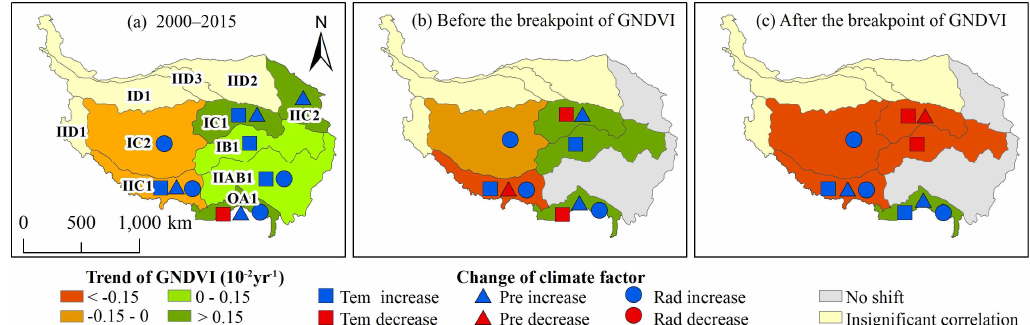
Figure 7. Spatial distribution of changes in growing season NDVI (GNDVI), temperature (Tem), total precipitation (Pre), and radiation (Rad) during different periods before and after the breakpoints according to Figure 4. The trends in GNDVI, temperature (Tem), total precipitation (Pre), and radiation (Rad) were shown in panel during 2000–2015 ( a ), before the breakpoint ( b ), and after the breakpoint of GNDVI ( c ). Time lag of temperature (Tem), total precipitation (Pre), and radiation (Rad) were based on Figure 5.